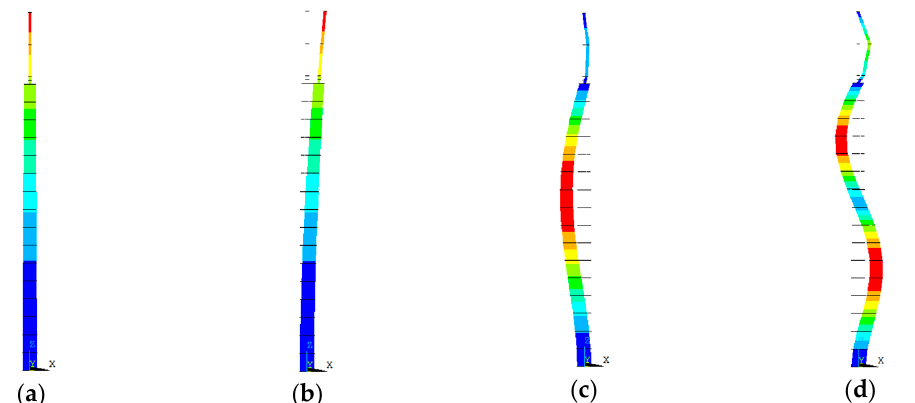
Figure 10. ( a ) BEM and ( b – d ) the first three mode shapes of the 4 m-mast H-type VAWT in the X-Y plane: ( b ) the first mode shape with the natural frequency of 1.941 Hz, ( c ) the second mode shape with the natural frequency of 48.556 Hz, and ( d ) the third mode shape with the natural frequency of 150.54 Hz.